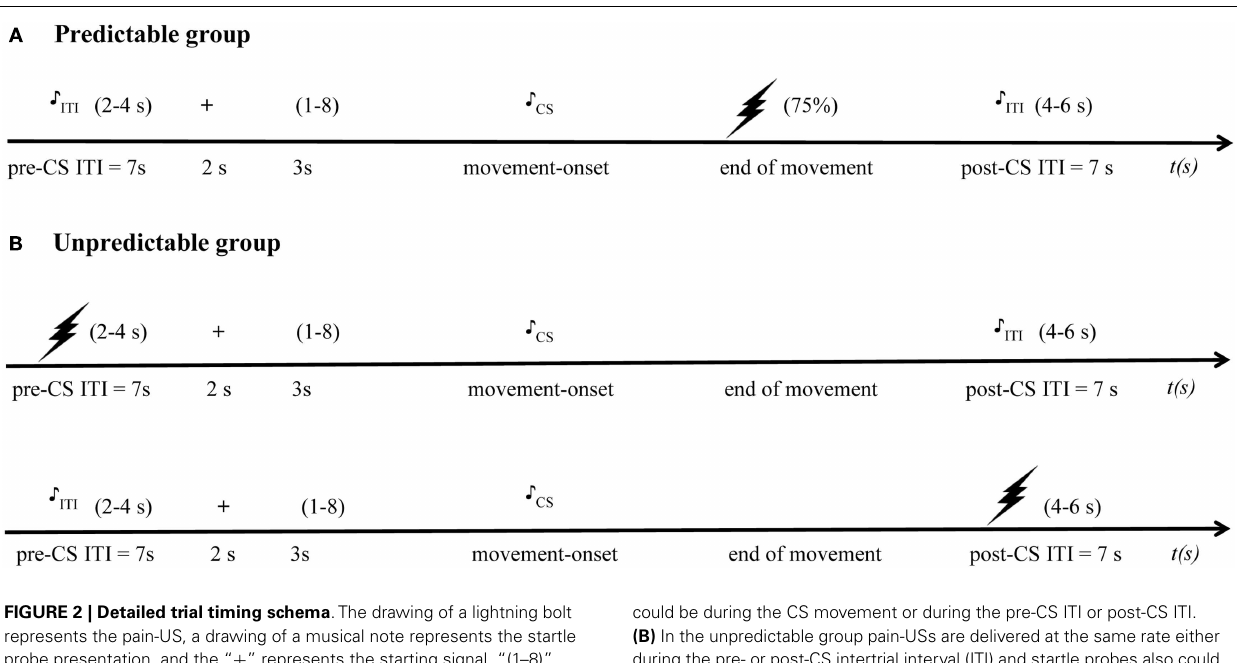
FIGURE 2 | Detailed trial timing schema .The drawing of a lightning bolt represents the pain-US, a drawing of a musical note represents the startle probe presentation, and the “ + ” represents the starting signal, “(1–8)” refers to the presentation of a number between 1 and 8 representing the quadrant in which the participants have to move. (A) In the predictable group, during the acquisition phase, pain-USs are delivered in 75% of the trials after the CS+ movements, but not after the CS- movements. On each trial only one startle probe was presented: in the predictable group, this